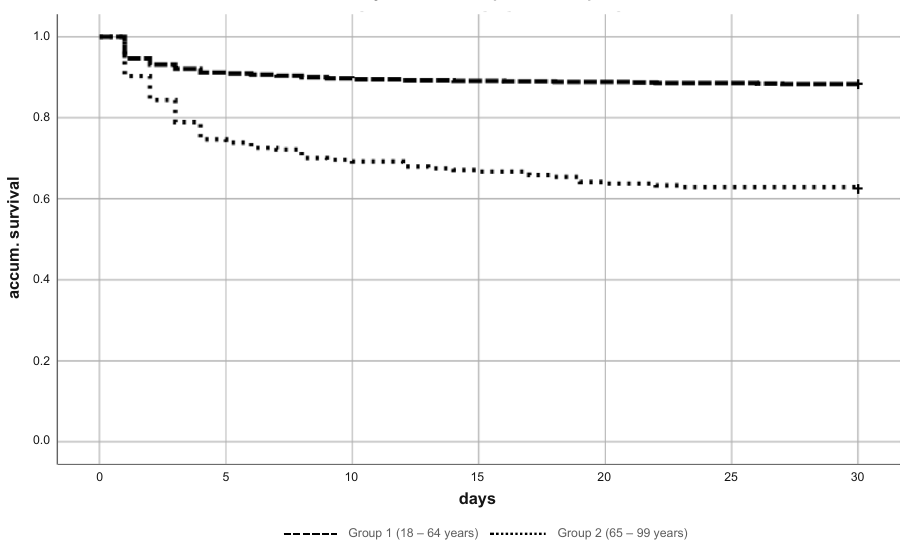
Figure 3. Kaplan–Meier curve of 30-day survival severely injured patient (ISS ≥ 16) Group 1 vs. Group 2.